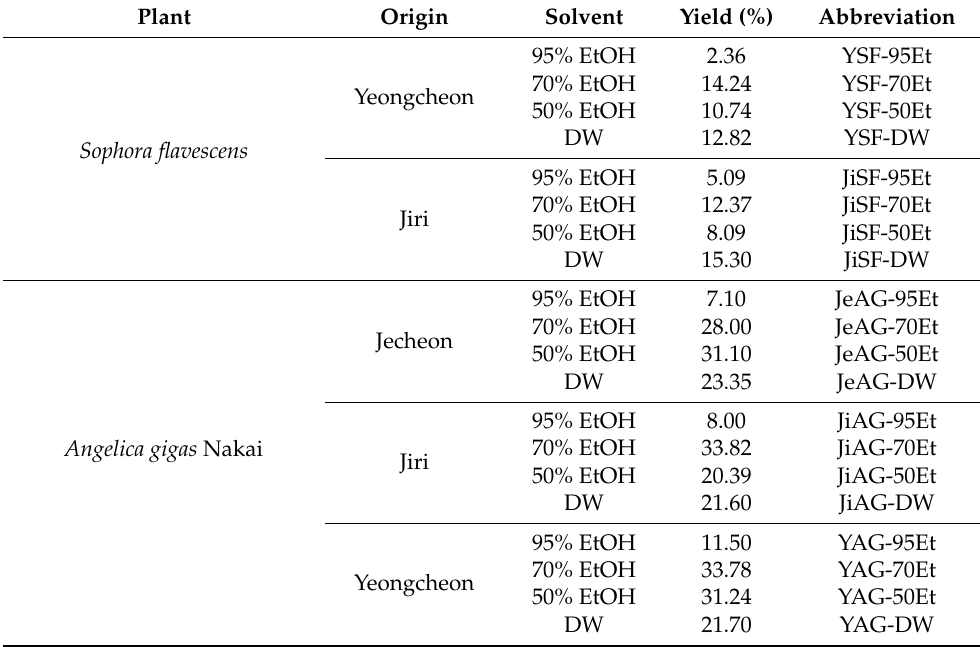
Table 1. Comparison of the yield of extract according to the plant, origin, and solvent.